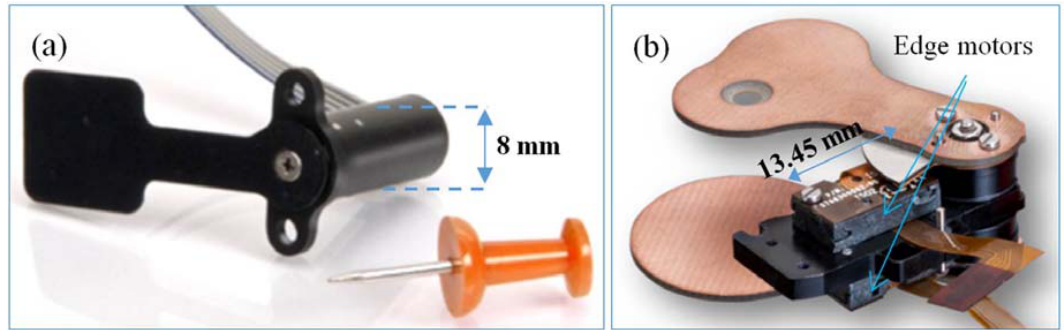
Figure 16. ( a ) Image of a rotary NUC shutter based on a 9 mm long L1B2 element. The length of the unit is 20 mm. ( b ) An image of a shutter module with two rotary axes.